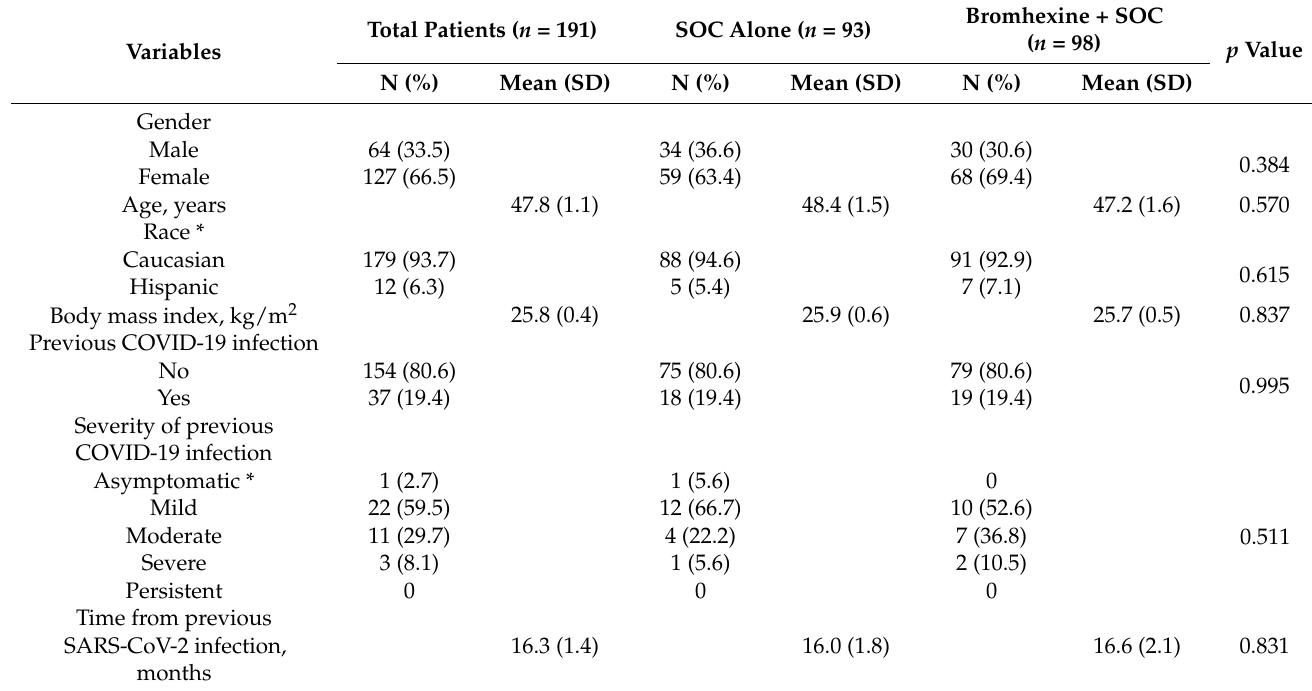
Table 1. Demographic and previous SARS-CoV-2 infection in the study groups.